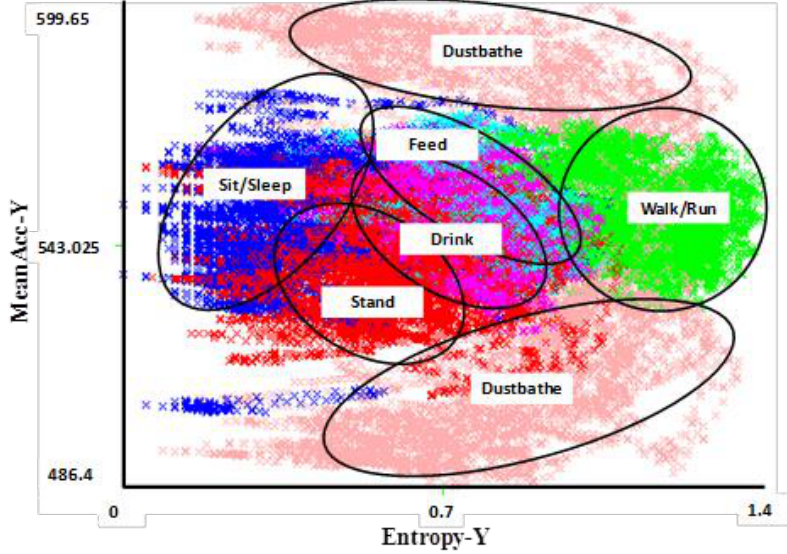
Figure 1. Visual clustering of activities in a 2D feature space for Y and X axis accelerometer data [38]. The different behavioral activities appear as different distinct clusters, allowing them to accurately be distinguished from each other. The most difficult behaviors to distinguish are feeding and drinking, both of which involve a stationary body with pecking motion of the head (upwards in the case of drinking and downwards in the case of feeding). Data were collected from six sensor-wearing hens over several days to capture multiple performances of an activity by each hen. The clusters shown here correspond to classifications using the 50% test dataset.